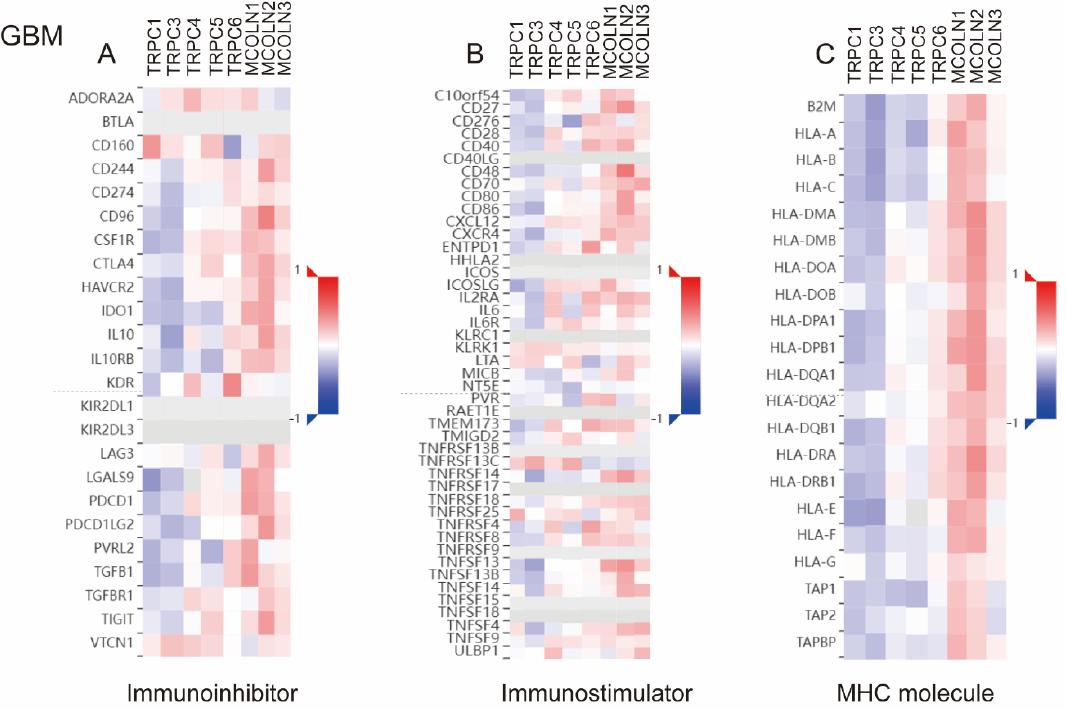
Figure 8. Correlations Between Hub Genes and the Expression of Immunoregulators in Glioma. The correlation between the expression of TRPC1, TRPC3, TRPC4, TRPC5, TRPC6, MCOLN1, MCOLN2, and MCOLN3 and immunoinhibitors ( A , D ), immunostimulators ( B , E ), and MHC molecules ( C , F ) was calculated based on the TISIDB database.